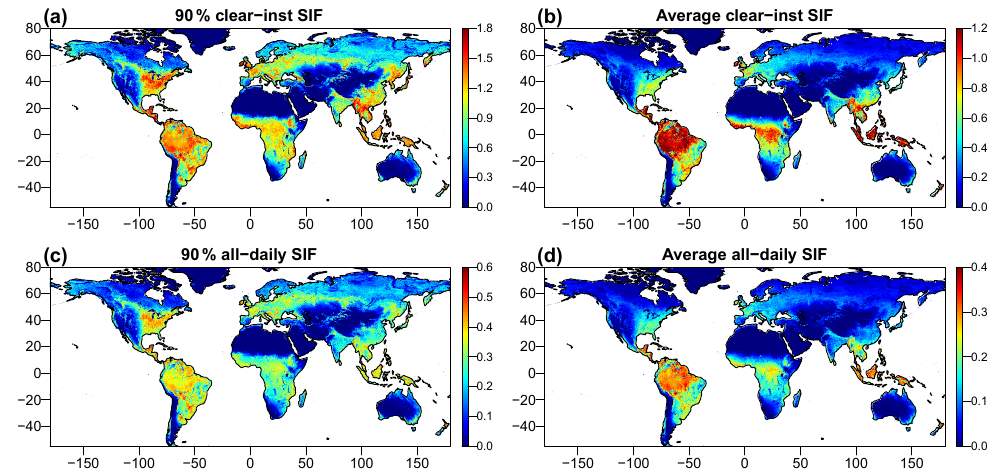
Figure 6. Spatial pattern of maximum (90th percentile) and average daily values for instantaneous clear-sky SIF and all-sky daily SIF. All values are in units of mWm − 2 nm − 1 sr − 1 .